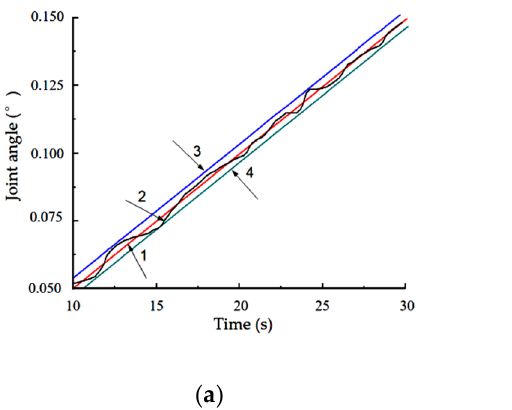
Figure 14. Comparative analysis. ( a ) Angular position curve with a velocity of 0.005 °/s under LuGre friction model control of identification of whole parameter by GA; ( b ) angular position curve with a velocity of 0.005 °/s under LuGre friction model control of piecewise parameter identification by GA-PSO.